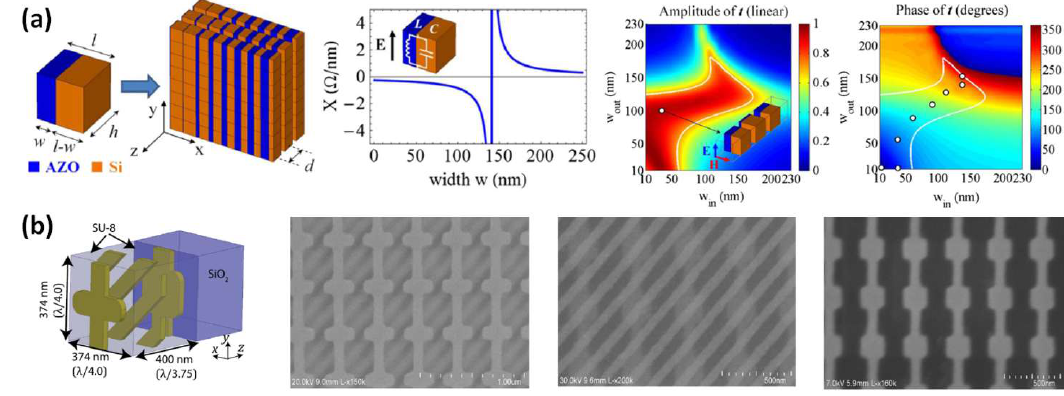
Figure 4: Left-to-right: (a) From [91]: Schematic showing a basic building block of a multilayer, impedance matched metasurface consisting of two materials with real permittivities of opposite sign (i.e. plasmonic and dielectric). As an example aluminium doped zinc oxide (AZO) and silicon were chosen respectively at a working wavelength of 3 µ m. Here l = 250 nm and h = 250 nm. By varying the width of the block a wide range of reactance (per unit length) can be obtained. Color maps demonstrate the transmission amplitude and phase as a function of width of the block. High transmission eflciencies (> − 3 dB) and full control of the phase can be seen (enclosed by white contour lines). (b) From [93]: Schematic and SEM images showing a cascaded series of Ti/Au metasurfaces that together function as an asymmetric circular polarizer, due to magnetic response generated via interactions between the sheets, in addition to each individual tangential electric field response. Note that overall device thickness is still subwavelength and can be modelled as a single bianisotropic metasurface. Adapted with permission from Refs [91, 93]. Copyright 2013, 2014, American Physical